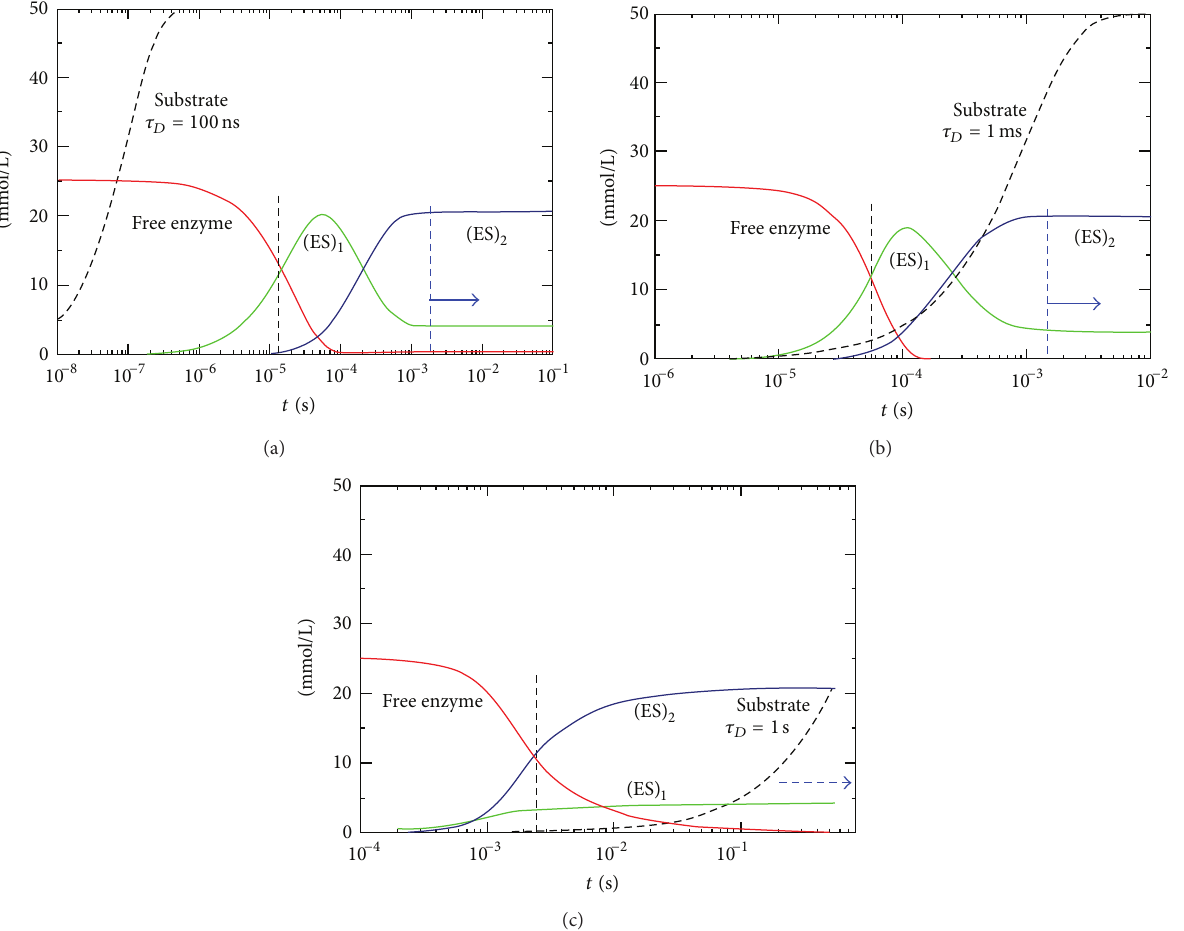
Figure 5: Concentration profiles of free enzyme (red), (ES) 1 complex (green), and (ES) 2 complex (light blue); substrate in black. Vertical black dashed lines: relaxation time of the free enzyme, vertical blue dashed lines: beginning of steady state. (a) Caged substrate, activation, and diffusion times much faster than binding, instantaneous activation, (b) mixing, crystal size 3 × 4 × 5 𝜇 m 3 , and diffusion times on the order of the of the turnover time, (c) mixing, crystal size 100 × 120 × 140 𝜇 m 3 , and diffusion time much slower than the turnover